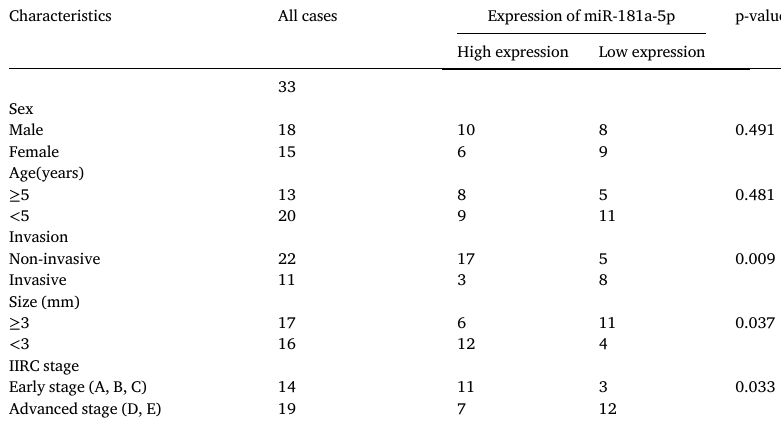
Table 2 Correlation between microRNA (miR)-181a-5p expression and the characteristics of RB